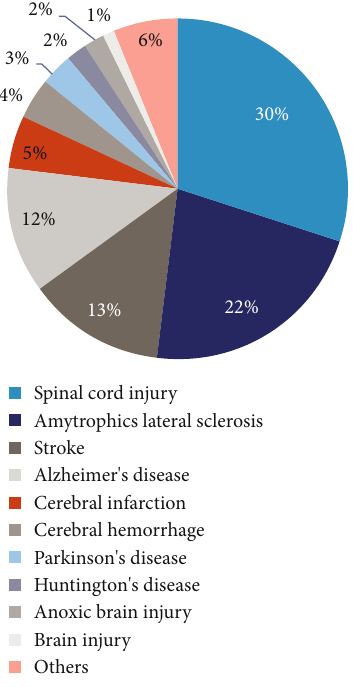
Figure 1: Proportion of di ff erent nerve disease types for which MSCs were used as a treatment in clinical